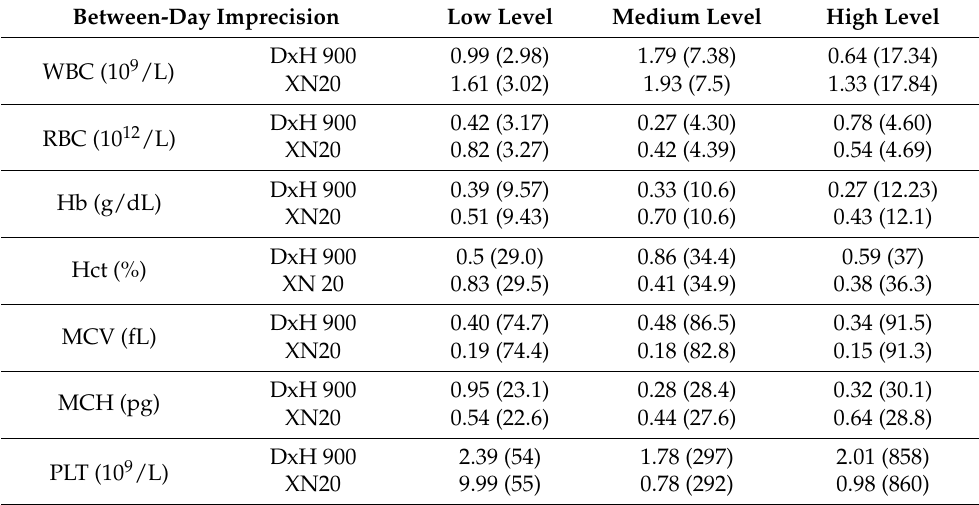
Table 2. Coefficients of variation (CV%) for within-day imprecision analysis for 10 repetitions in a day. Between-Day Imprecision Low